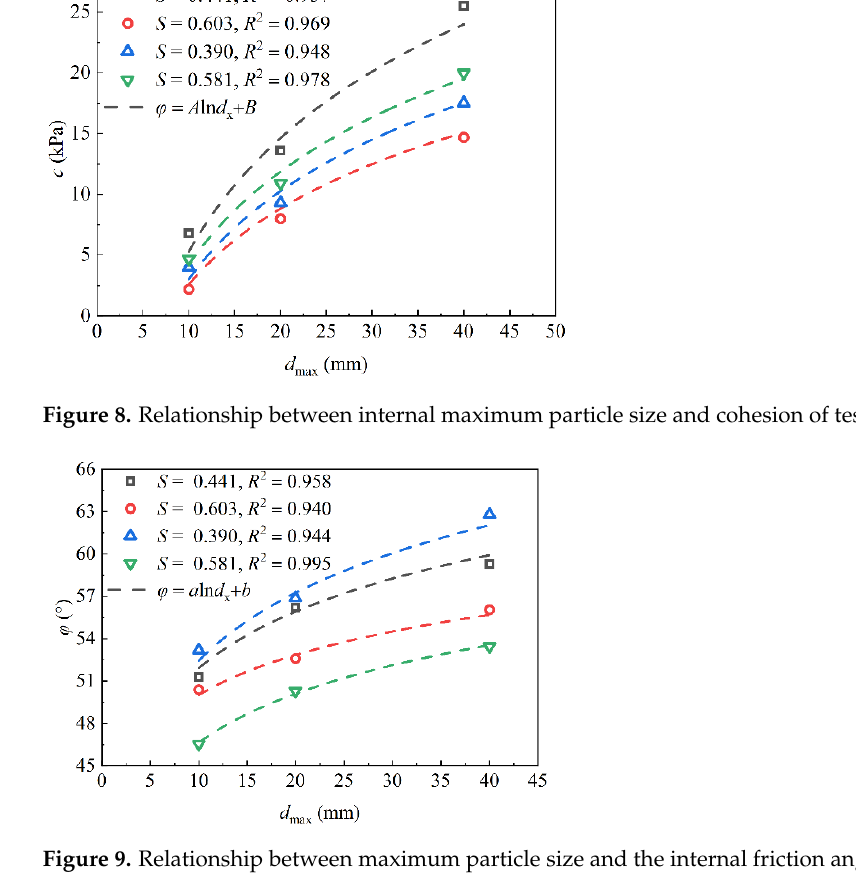
Figure 9. Relationship between maximum particle size and the internal friction angle of test CGS.